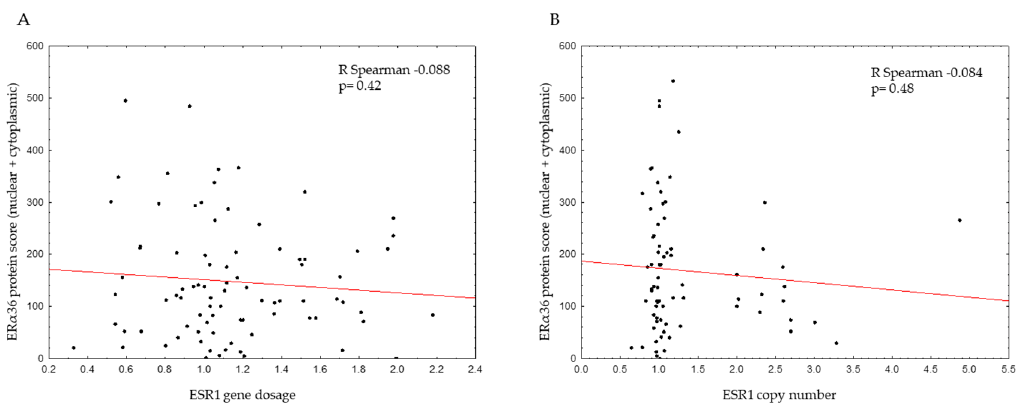
Figure 4. Correlation between ER α 36 protein score (total nuclear and cytoplasmic score and ESR1 gene dosage (measured by qPCR) ( A ) or ESR1 copy number (measured by FISH) ( B ).